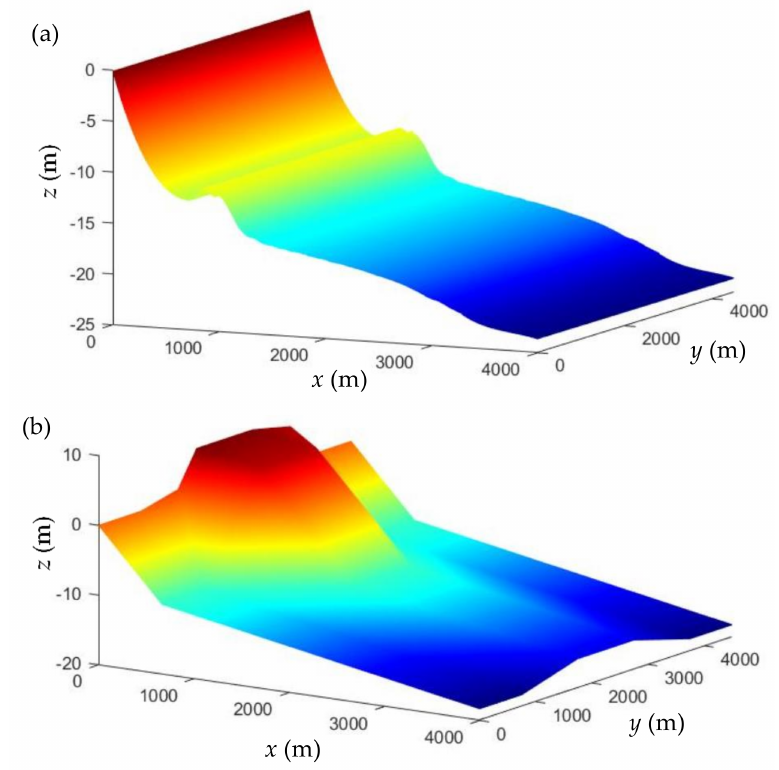
Figure 3. Tested seafloors: ( a ) longshore bar; ( b )